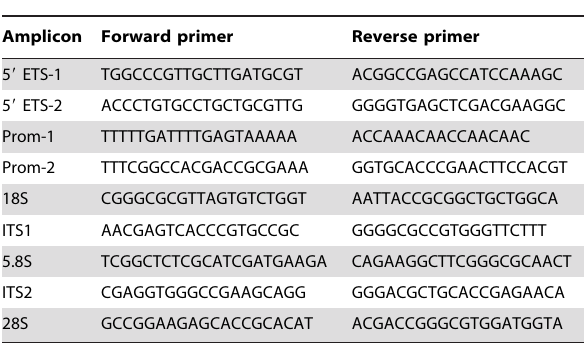
Table 1. Primers used for quantitative analysis and DNA methylation